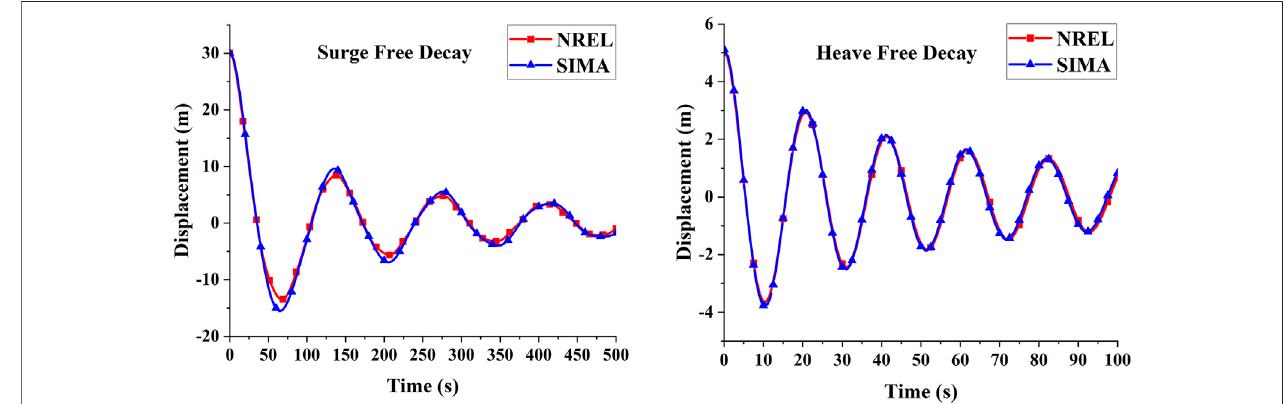
FIGURE 2 | Results of the free-decay test. (A) Surge decay test. (B) Heave decay test.